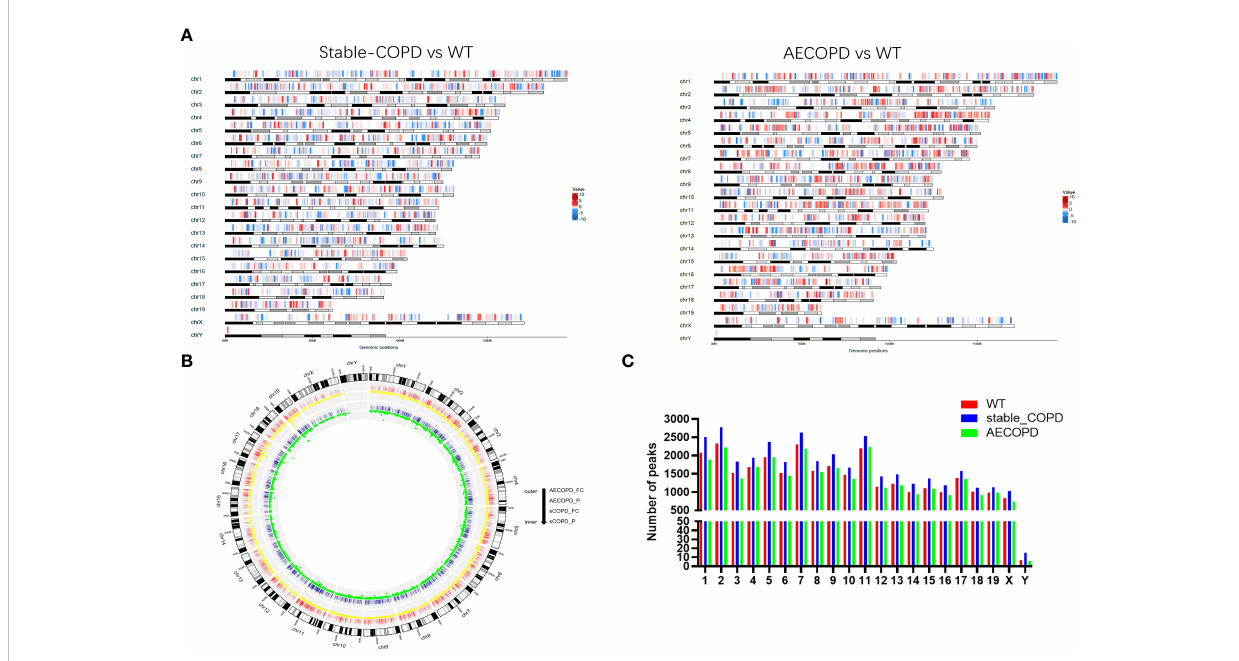
FIGURE 3 Distribution of differentially methylated m6A sites: (A) Distribution of all DMM sites in mRNAs and lncRNAs on chromosomes; (B) density distribution of m6A peak along chromosomes; (C) quanti fi cation of m6A peak on each chromosome. DMM: differentially methylated N6